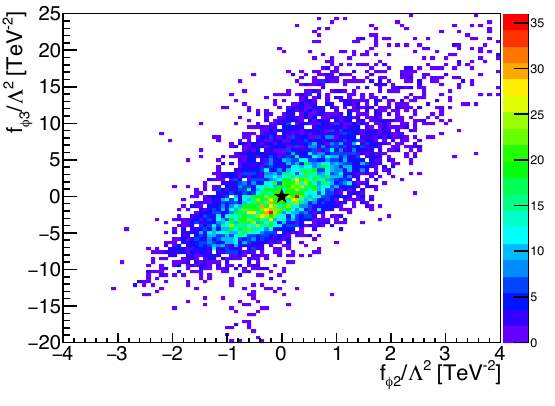
Figure 3: Correlations between the leading operators describing Higgs pair produc-